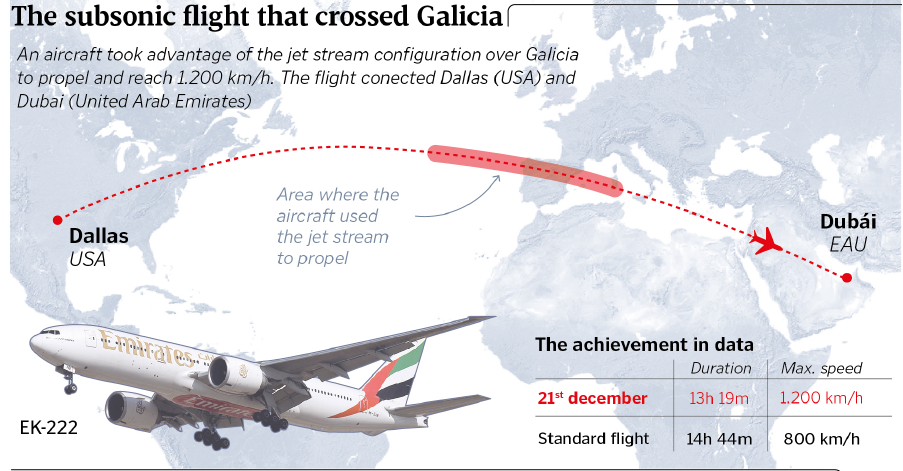
Figure 2. This graphic explains the characteristics of the Emirates Airline flight that reached a speed of 1200kmh − 1 on 21 December 2019 after taking advantage of the strong winds from the jet stream.